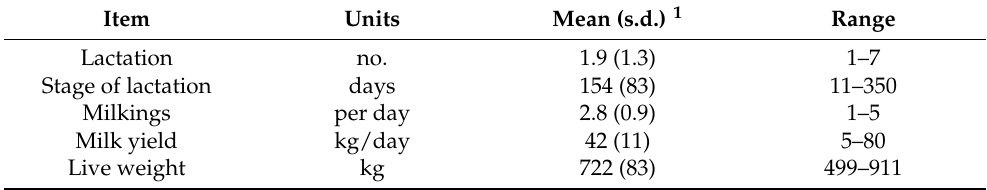
Table 1. Average production values for cows in the study ( n =